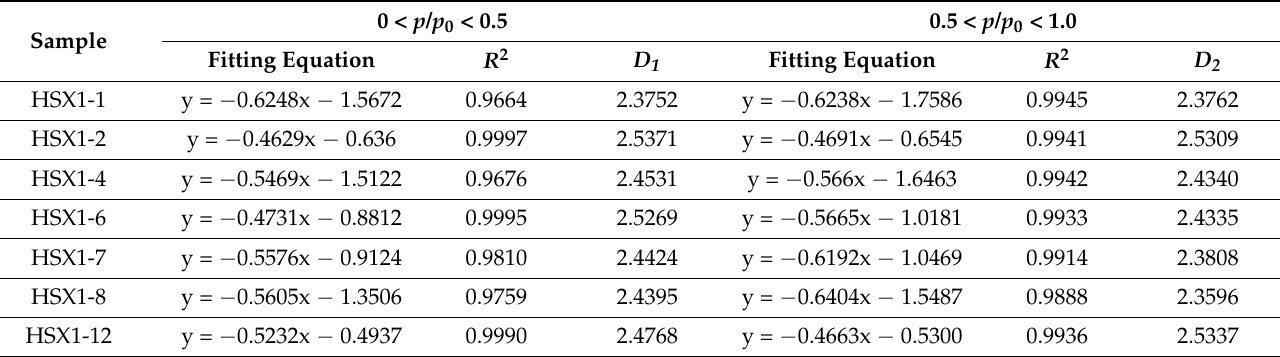
Figure 7. Fractal calculation results from ln ( V ) vs. ln (ln ( p / p 0 )) of N 2 adsorption from shales. Table 3. Fractal dimensions derived from the FHH model.